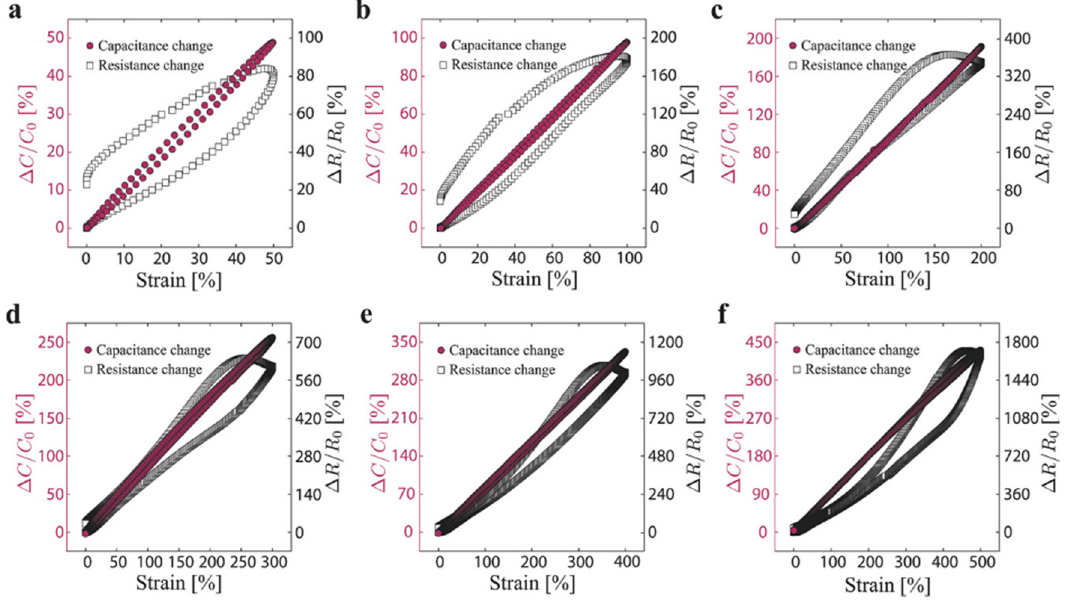
Figure 6. Comparison of capacitive and resistive strain sensor response for carbon black-filled elastomers under different strain amplitudes for ( a ) 50% ( b ) 100% ( c ) 200% ( d ) 300% ( e ) 400% and ( f ) 500% strain. Visible hysteresis can be seen in the resistive response between loading and unloading strain. Reproduced with permission from [167]. Copyright 2017, John Wiley and Sons.